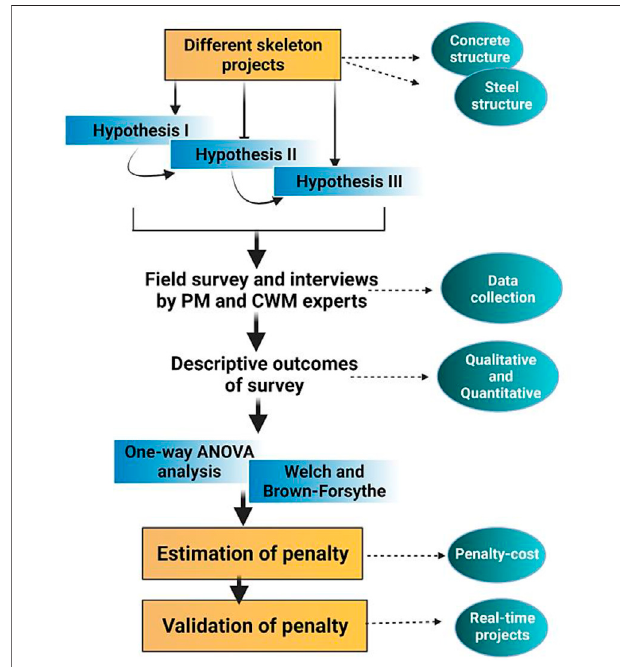
FIGURE 1 | The layout of the